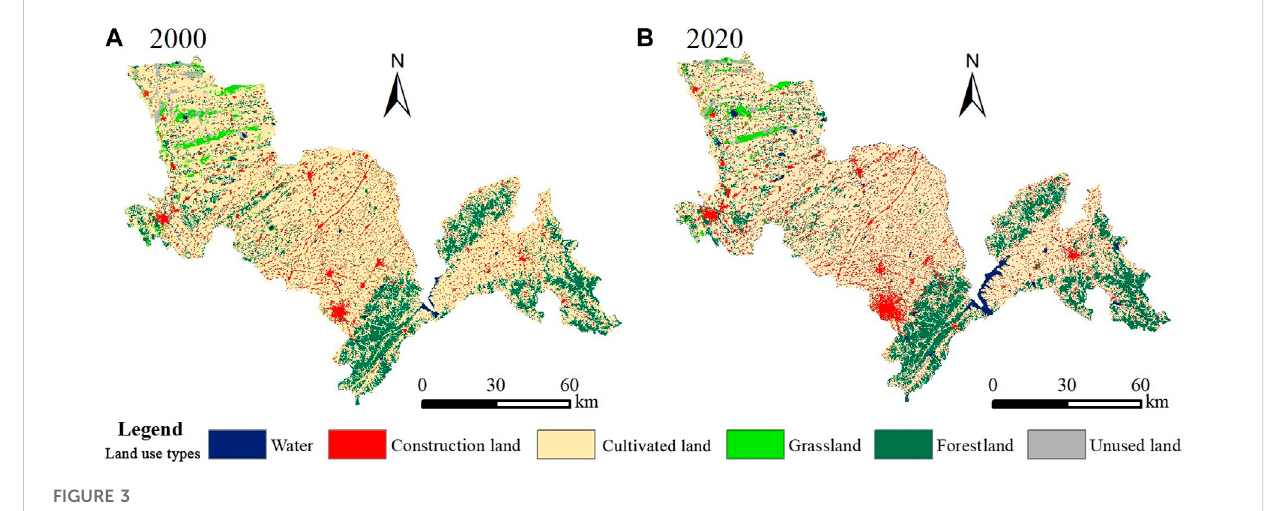
FIGURE 3 Land use map of Siping City in (A) 2000 and (B) 2020.